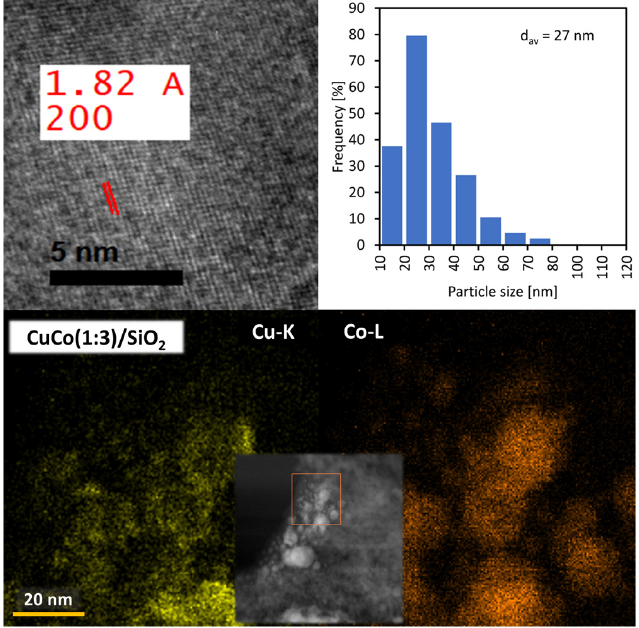
Figure 6. Interplanar distance, TEM mapping and particle size distribution of CuCo(1:3)/SiO 2 .